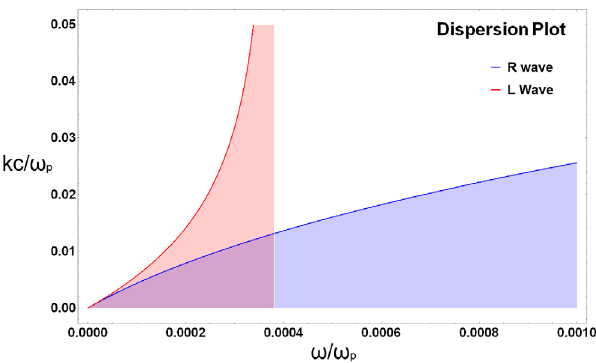
FIG. 7. Dispersion relation for right- and left-hand shear- Alfv´en waves in the low frequency